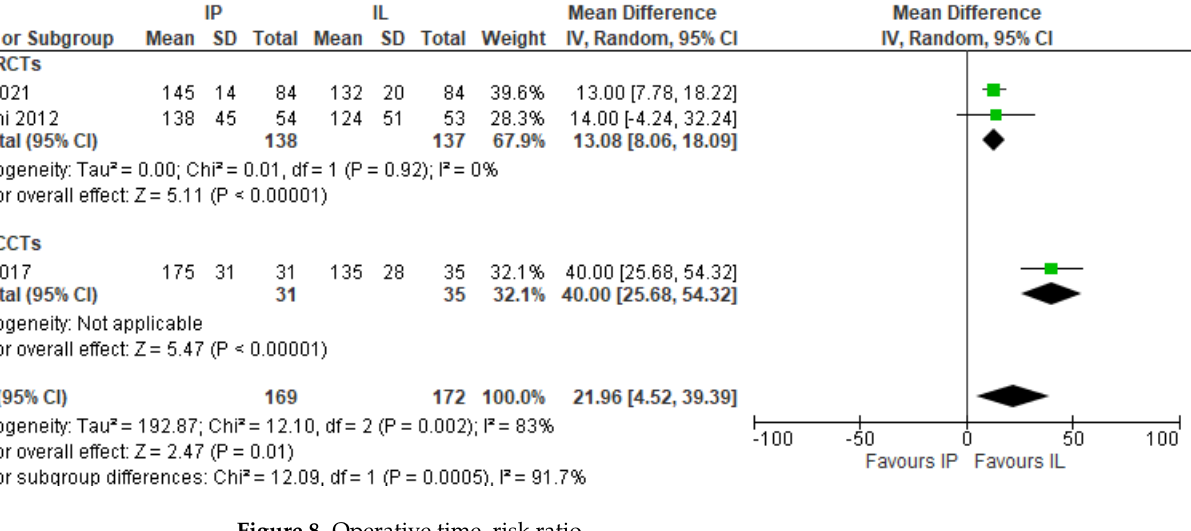
Figure 9. Operative time. Risk ratio for different IMA preservation techniques. 3.4.4. Conversion to Open Surgery This outcome was obviously evaluated only in the laparoscopic series (eight studies, 1990 patients) [18,20,21,23–27]. Conversion rate was significantly higher in the IMA preservation group, as follows: 7.64% vs. 4.29% (MD 1.65, 95% CI 1.10–2.47) (Figure 10).